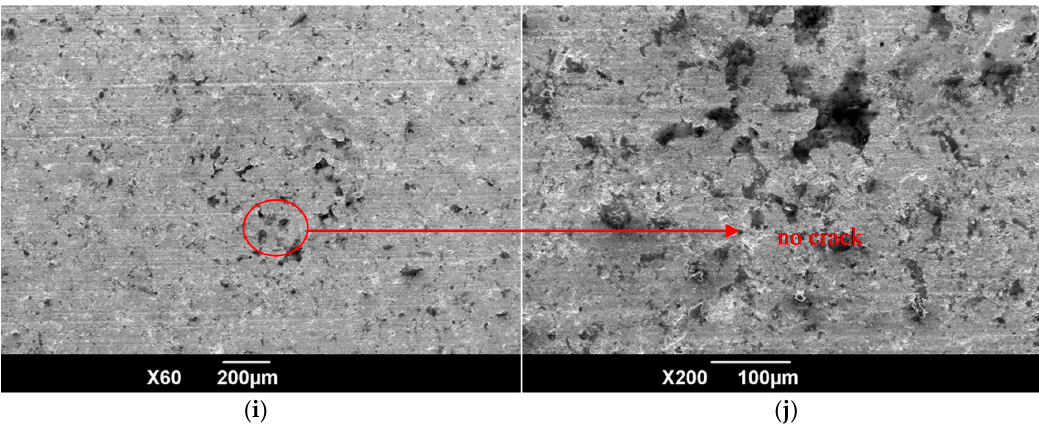
Figure 8. Experiment results of repeated impact for coatings: ( a ) SP + H (existing cracks); ( b ) SP + H enlarged image (existing cracks); ( c ) SP + H + DP (existing cracks); ( d ) SP + H + DP enlarged image (existing cracks); ( e ) SP + H + DP + SP1 (no crack); ( f ) SP + H + DP + SP1 enlarged image (no crack); ( g ) SP + H + DP + SP2 (no crack); ( h ) SP + H + DP + SP2 enlarged image (no crack); ( i ) SP + H + DP + SP3 (no crack); and ( j ) SP + H + DP + SP3 enlarged image (no crack).